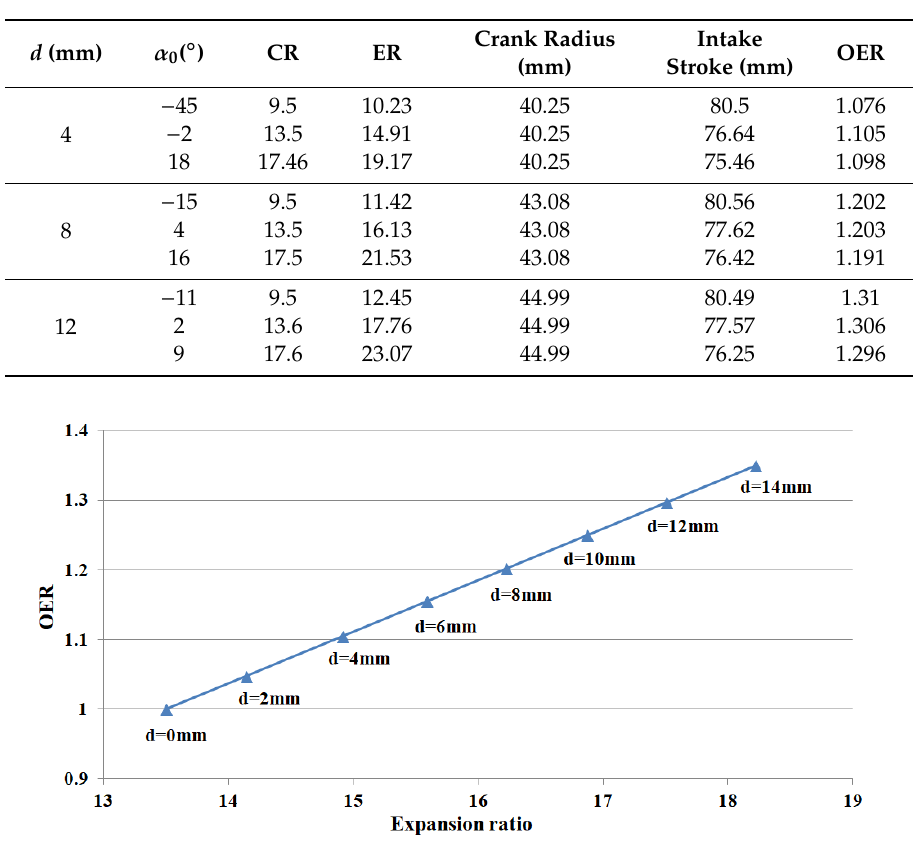
Figure 7. Variation of the OER with different d values and the ER for a CR = 13.5.